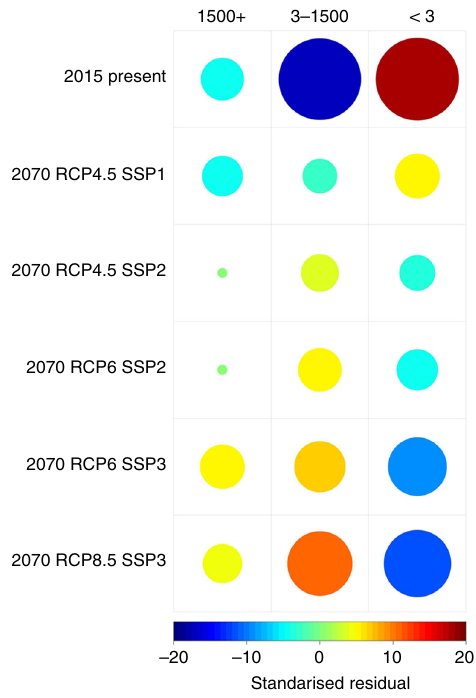
Fig. 6 Comparison of 2070 EMM simulation scenarios by EVD-EBOV fi nal outbreak size. Circles represents standardized residuals from a chi-squared test of association ( χ = 466.27, df = 10, p < 0.001) between simulation scenario and fi nal outbreak size category. More orange/red colours show a greater than expected (vs. randomly allocated) number of outbreaks for any given combination of scenario and fi nal outbreak size, with more blue colours representing fewer than expected outbreaks. Size of circle also indicates the overall quantity different to expected, with large circles contributing more to the overall chi-value compare to smaller